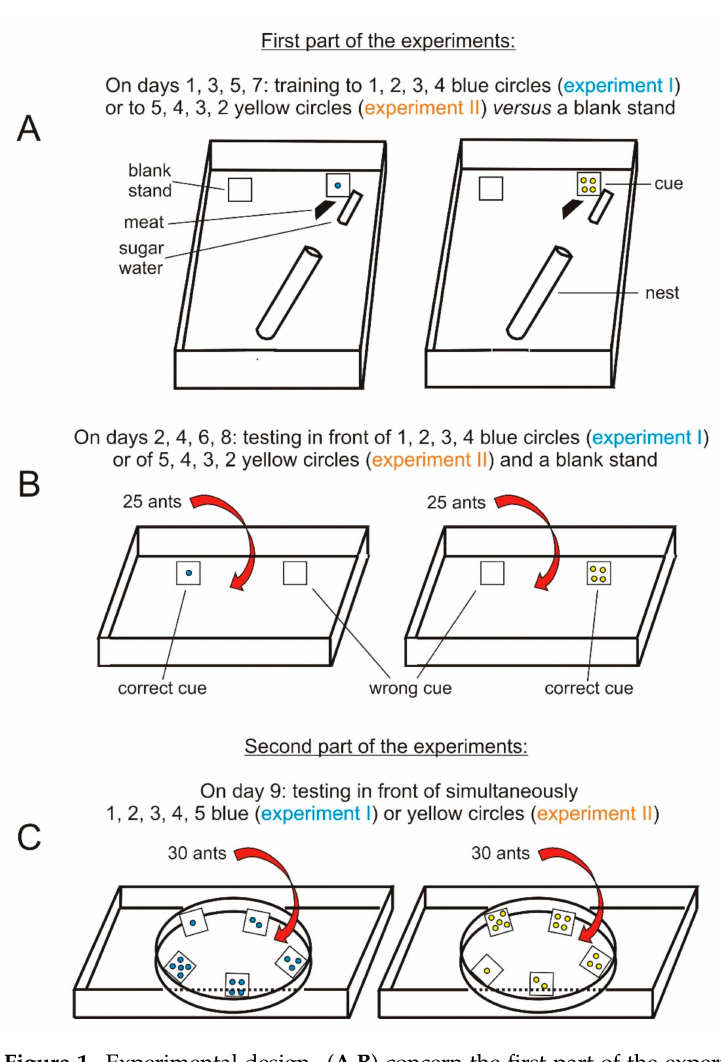
Figure 1. Experimental design. ( A , B ) concern the first part of the experiments: the ants of each of the two colonies were trained in their foraging areas to “correct” cues set near their food, which were successively 1 to 4 blue circles and thereafter 5 to 2 yellow circles, each of them versus 0 circles (a blank stand representing the “wrong” cue) set far from food. After each training using a number of circles, this conditioning was assessed by testing the ants in front of the “correct” and the wrong cues. ( C ) concerns the second part of the experiments: the ants were tested in front of 1, 2, 3, 4, and 5 circles placed along the rim of a circular